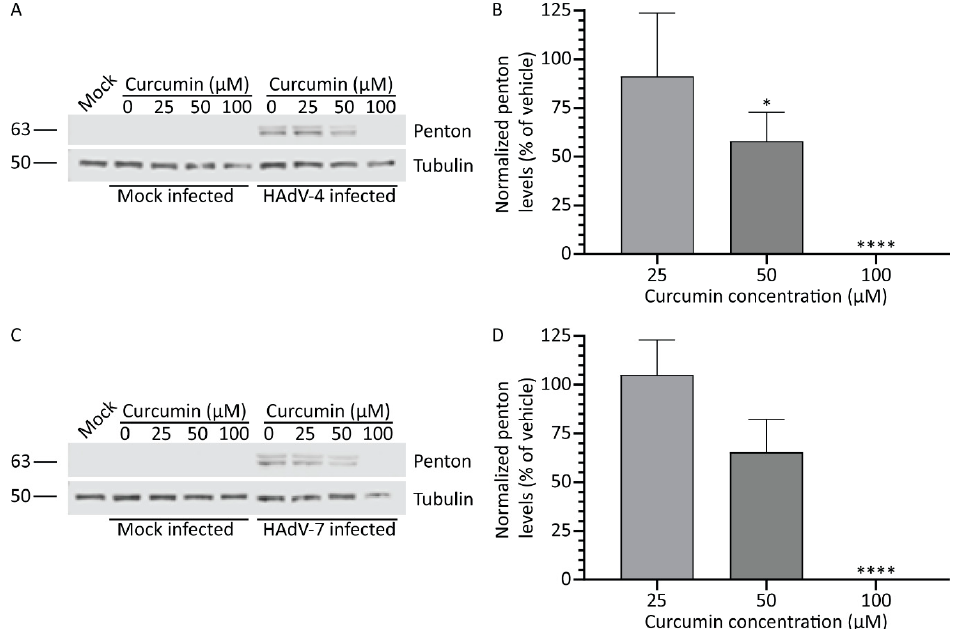
Figure 6. Treatment with curcumin reduces HAdV types 4 and 7 protein levels. A549 cells were infected with HAdV-4 or -7 at an MOI of 10 for 1 h, and overlaid with medium containing curcumin (0, 25, 50, and 100 µM). Twenty-four hpi, crude cell protein extracts were prepared and analyzed by immunoblot for late protein levels. ( A ) Samples infected with HAdV-4 were analyzed for expression of several late HAdV proteins by immunoblot using an α -HAdV-5 antibody. ( B ) Quantification of penton protein from HAdV-4 (~63 kDa major band) normalized to tubulin. Values are presented relative to vehicle-treated cells. ( C ) Samples infected with HAdV-7 were analyzed for expression of several late HAdV proteins by immunoblot using an α -HAdV-5 antibody. ( D ) Quantification of penton protein from HAdV-7 (~63 kDa major band) normalized to tubulin. Values are presented relative to vehicle-treated cells. The mean of three experiments are shown, and the error bars represent standard deviation (SD) of the mean. * p ≤ 0.05, **** p ≤ 0.0001. Microorganisms 2020 , 8 , x FOR PEER REVIEW